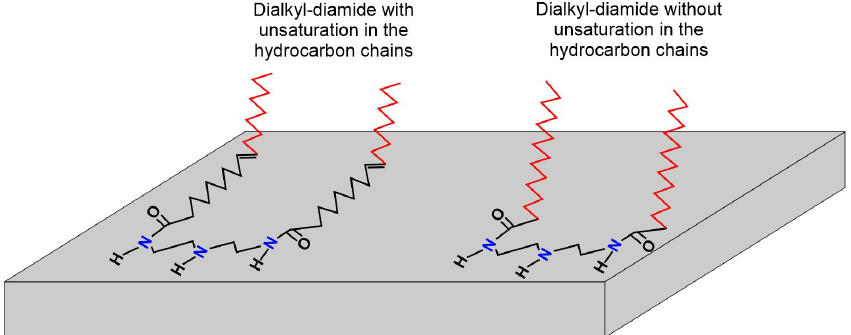
Figure 7. Schematic of the inhibitor adsorption mode onto metal surface.